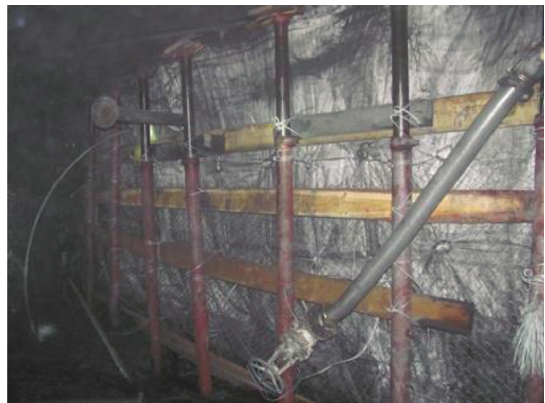
Figure 8: The mold bag hung on the roof.